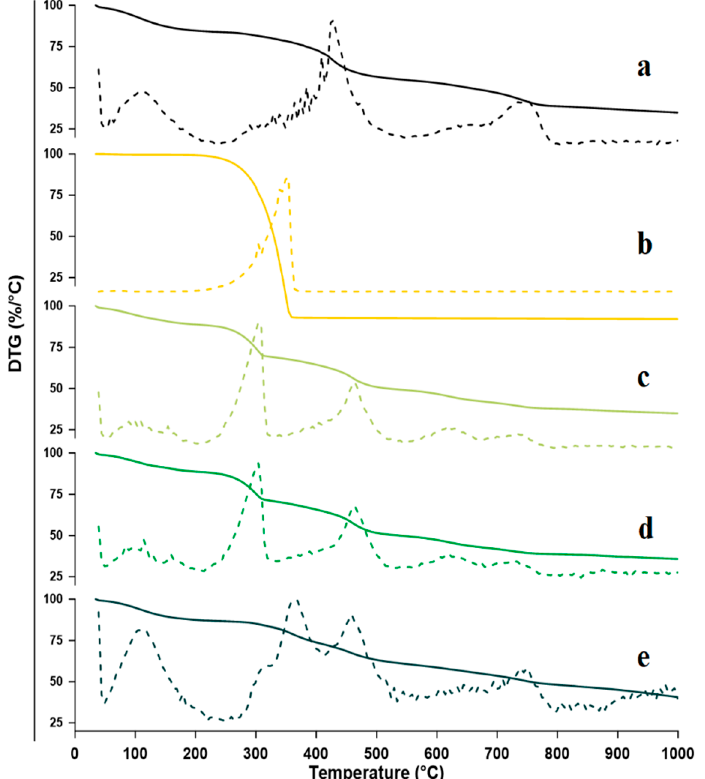
Figure 4. TGA/DTG curves for: ( a ) Sulfonatocalix[4]naphthalene, ( b ) fluconazole (FZ) ( c ) Physical mixture (PM) ( d ). Kneaded (KN) and ( e ) co-evaporate powder (CO).